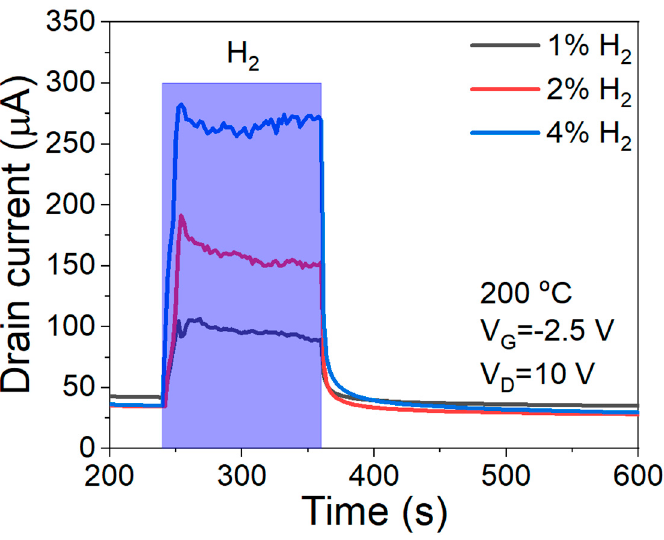
◦ Figure 7. Response to H 2 gas of S3 sensor at 200 °C. Figure 7. Response to H 2 gas of S3 sensor at 200 Figure 7. Response to H 2 gas of S3 sensor at 200 °C.